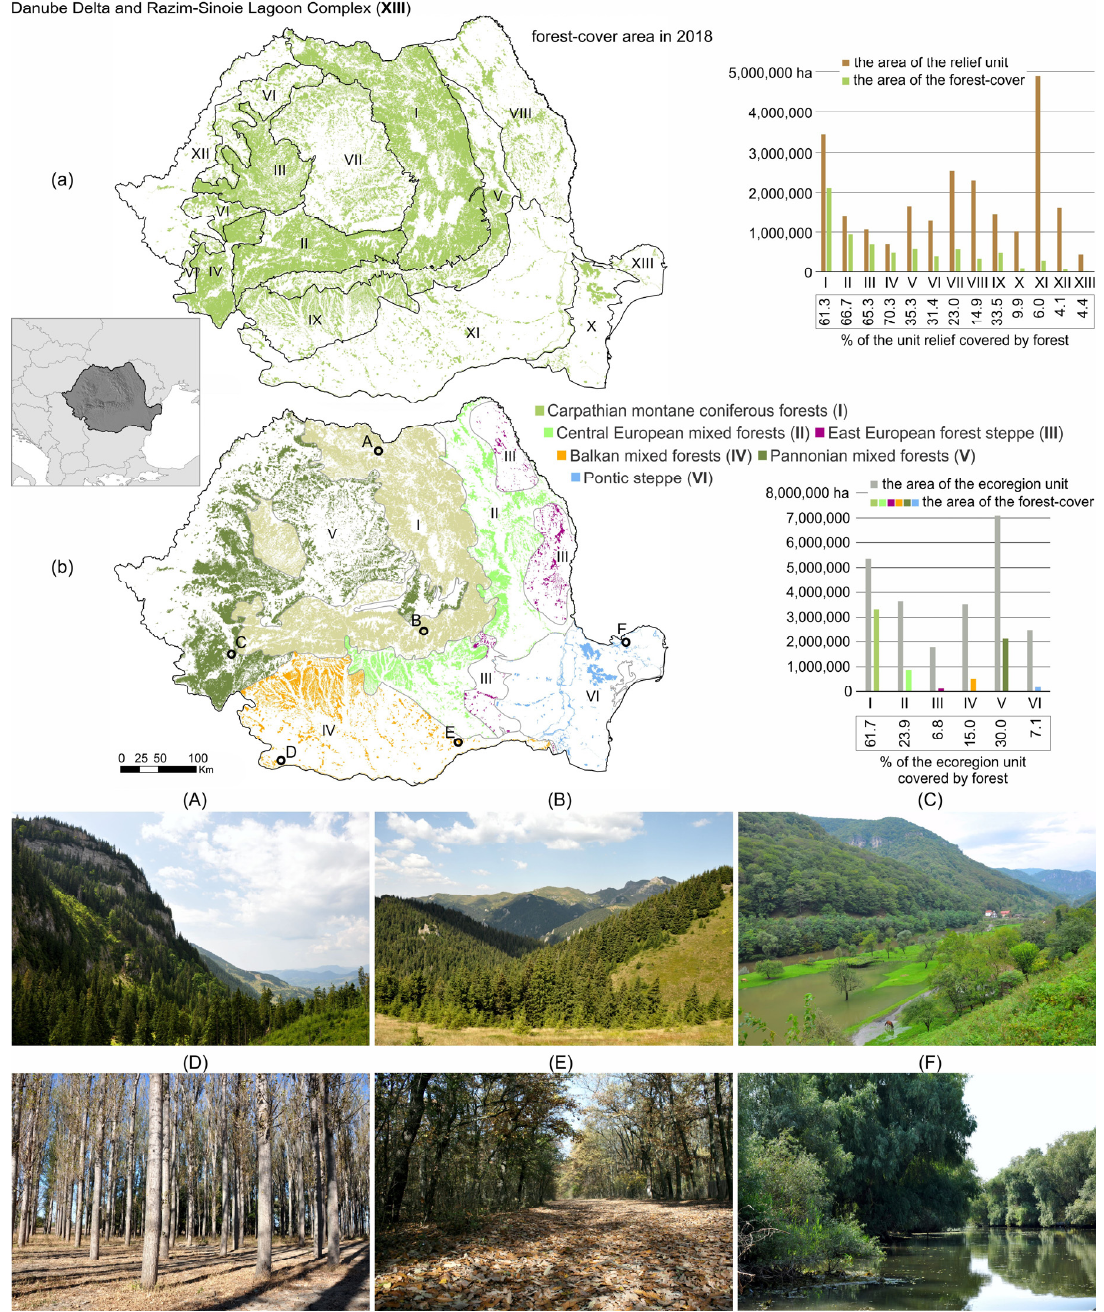
Figure 1. Location of the study-area and the forest-cover distribution over major relief units ( a ), major vegetation ecoregions ( b ) and some typical examples of forest-dominated landscapes in the mountain areas ( A – C ), Danube Valley ( D ), Romanian Plain ( E ) and Danube Delta ( F ).